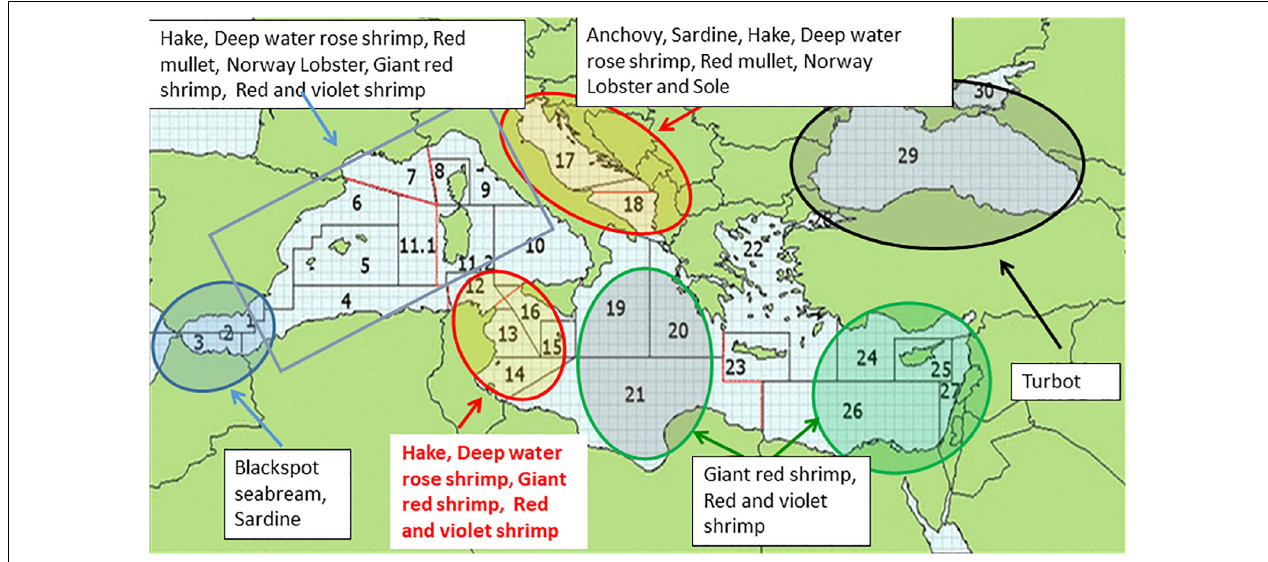
FIGURE 1 | The Mediterranean, the Black Sea, and the geographical sub-areas (GSAs) adopted by the General Fishery Commission for the Mediterranean (GFCM). The marked areas show where demersal and small pelagic stocks are shared. Multiannual plans (MAPs) are adopted or being prepared by the EU ( rectangle ) or the GFCM ( ellipses